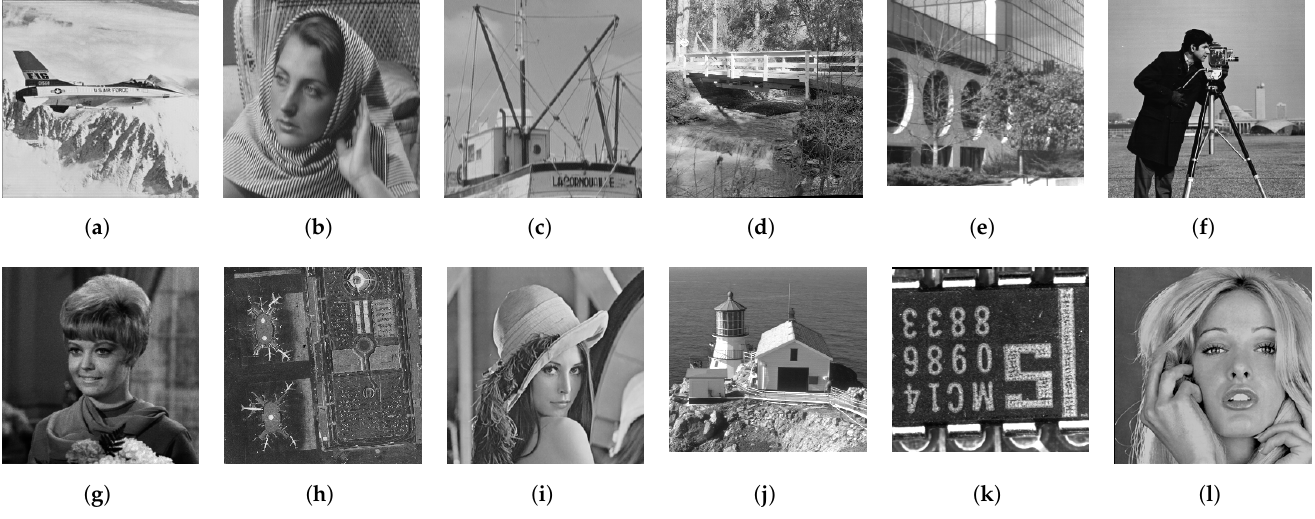
Figure 13. Grayscale images in the SIDBA image dataset [28]: ( a ) Airplane, ( b ) Barbara, ( c ) Boat, ( d ) Bridge, ( e ) Building, ( f ) Cameraman, ( g ) Girl, ( h ) Lax, ( i ) Lenna, ( j ) Lighthouse, ( k ) Text, ( l )